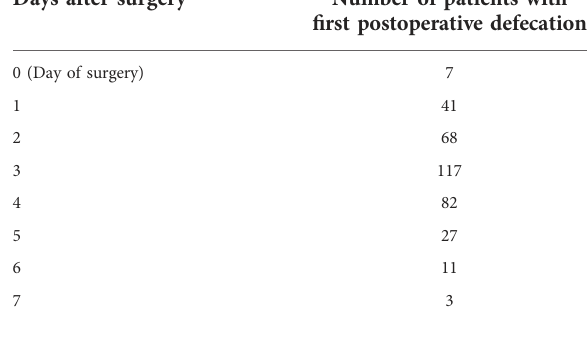
TABLE 4 Factors with increased and decreased POI